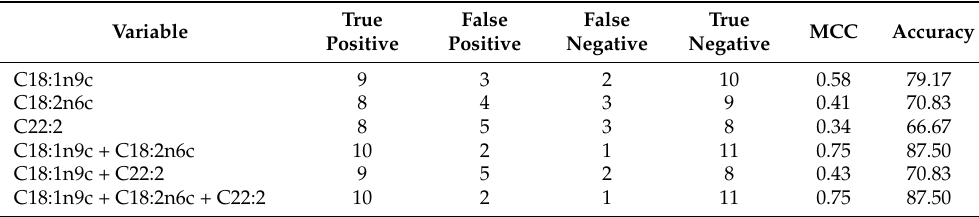
Table 4. Discriminant analysis of wool fatty acids and milk fat content, to determine the best classification of ewes with high milk fat